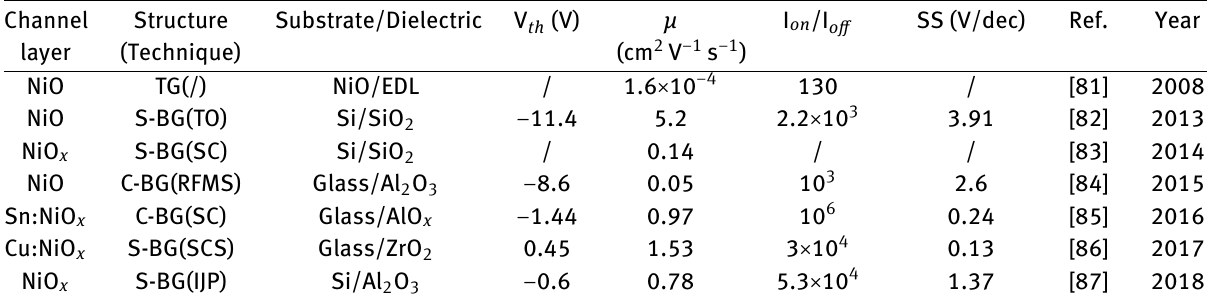
Table 3: Short-review of the reported p-type nickel oxide TFTs Channel layer